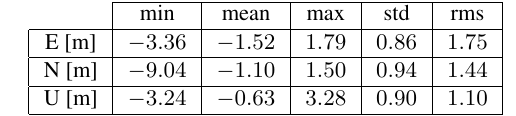
Table 1: Real time target tracking error statistics with respect to a local-level, Eeast-North-Up